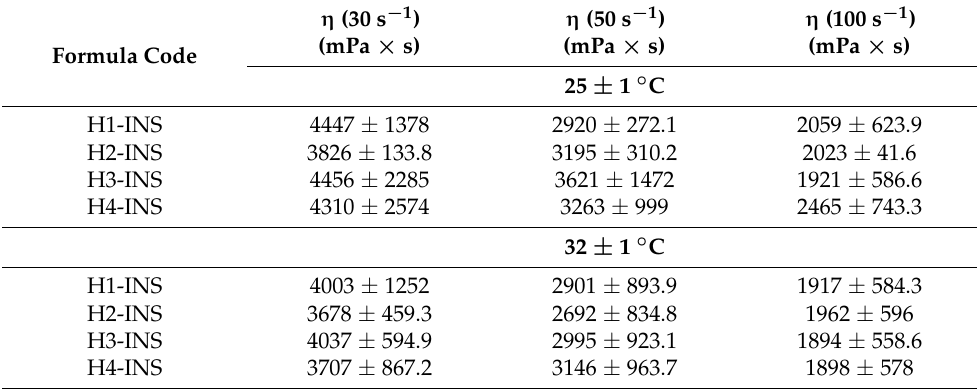
Table 4. Apparent viscosity values at different shear rates ±